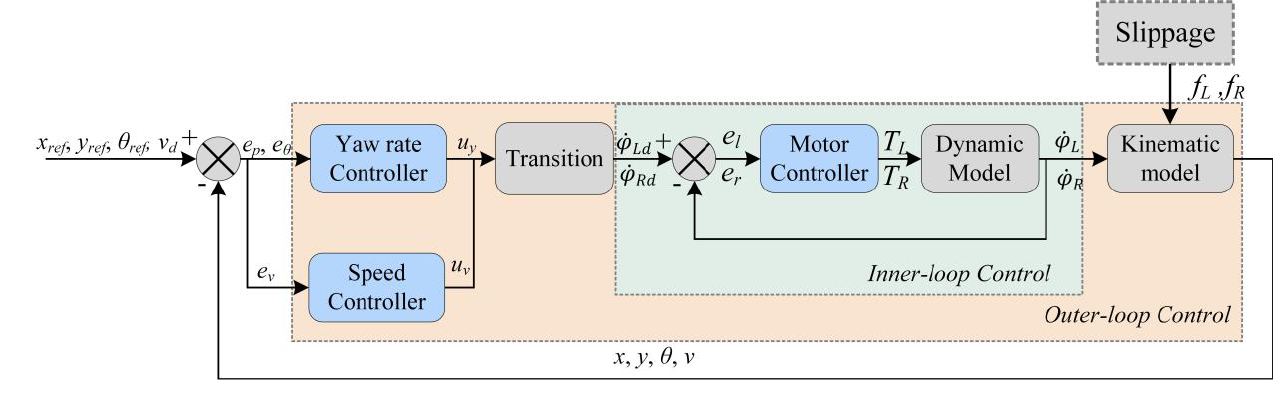
Figure 3. Configuration of the path tracking control framework. According to the configuration of the path tracking control framework from Figure 3, the real path can be output in Algorithm 1. Algorithm 1 Self-adaptive path tracking control algorithm based on RBF neural network